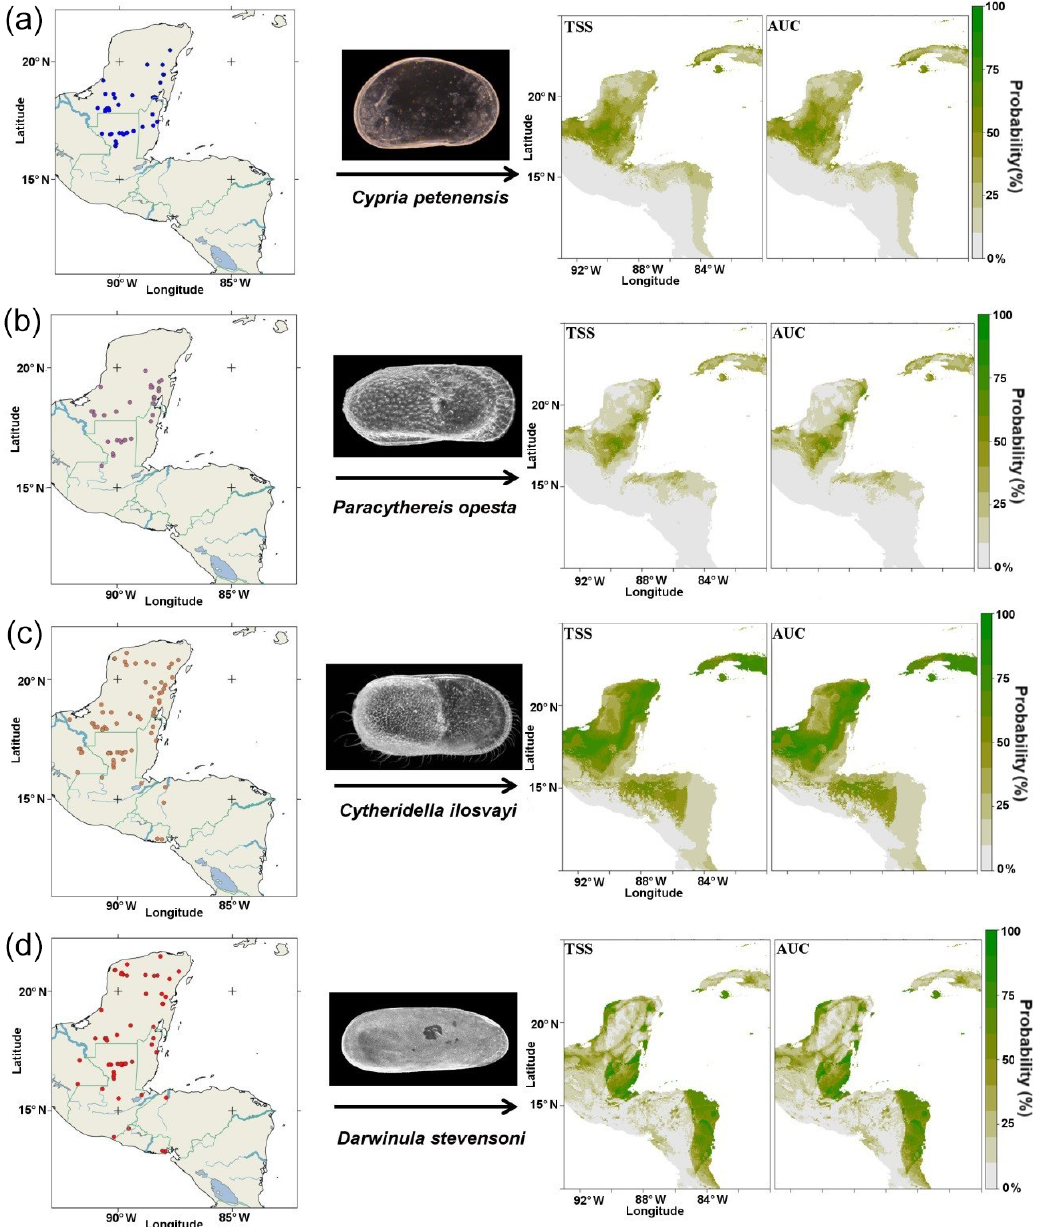
Figure 1. Current ostracode species distributions and predicted distribution based on species niche modelling and two statistical evaluations: true skill statistics (TSS) and area under the receiver operating characteristic curve (AUC). (a) Cypria petenensis , (b) Paracythereis opesta , (c) Cytheridella ilosvayi and (d) Darwinula stevensoni